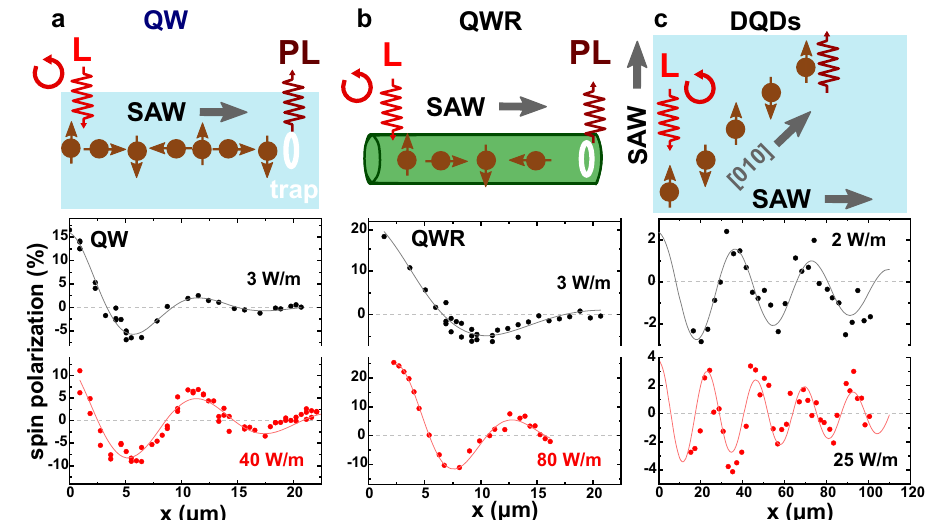
Fig. 3 | Acoustic control of the precession rate of moving spins. Spin polariza- tion, ρ s , during transport along ( a ) a quantum well (QW, excitation wavelength λ L =776 nm and power P exc =15 μ W, 20 K), ( b ) a quantum wire (QWR, λ L =776 nm, P exc =30 μ W (3 W m − 1 ) and P exc =150 μ W (80Wm − 1 ), 20 K), and ( c ) dynamic dots (DQDs, λ L =776 nm, 12 K) . The upper panels illustrate the experimental setup: